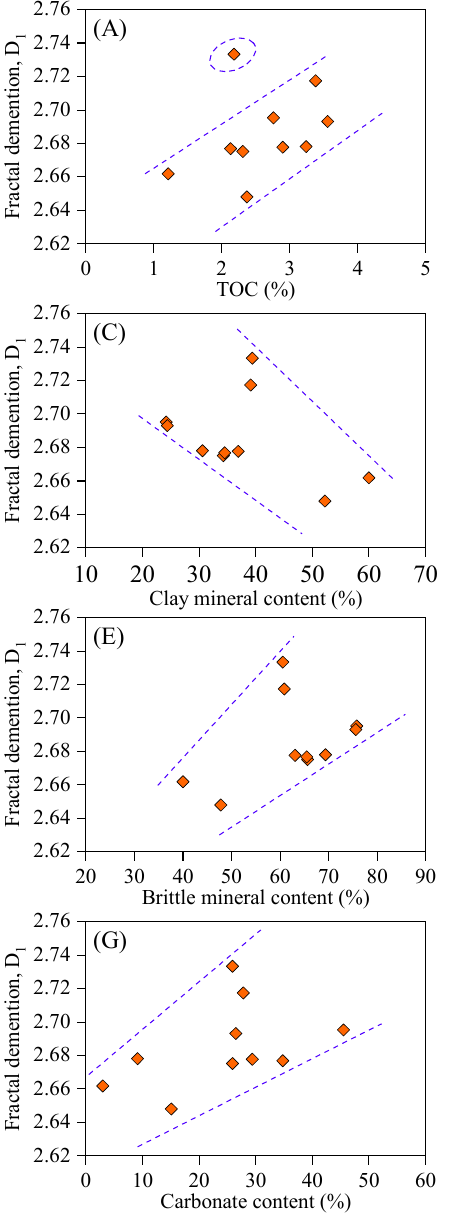
Figure 18. Relationships between fractal dimensions and TOC content ( A , B ), clay minerals ( C , D ), brittle minerals ( E , F ), and carbonate content ( G , H ).